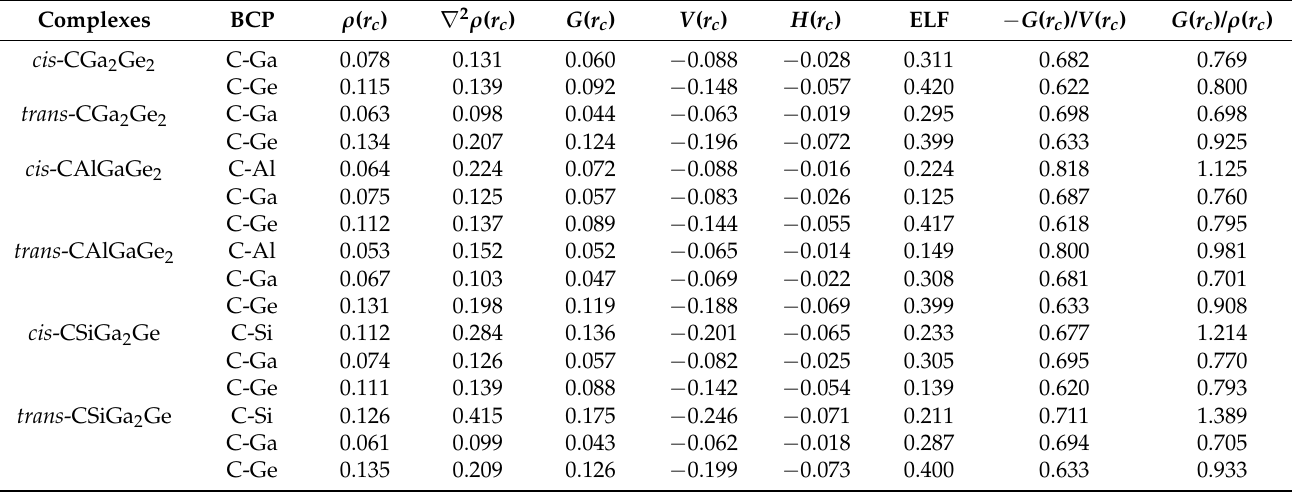
Table 3. Electron Density ( ρ (r c )), Laplacian of Electron Density ( ∇ 2 ρ (r c )), Kinetic Energy Density (G(r c )), Potential Energy Density (V(r c )), Total Energy Density (H(r c )) for the ptC